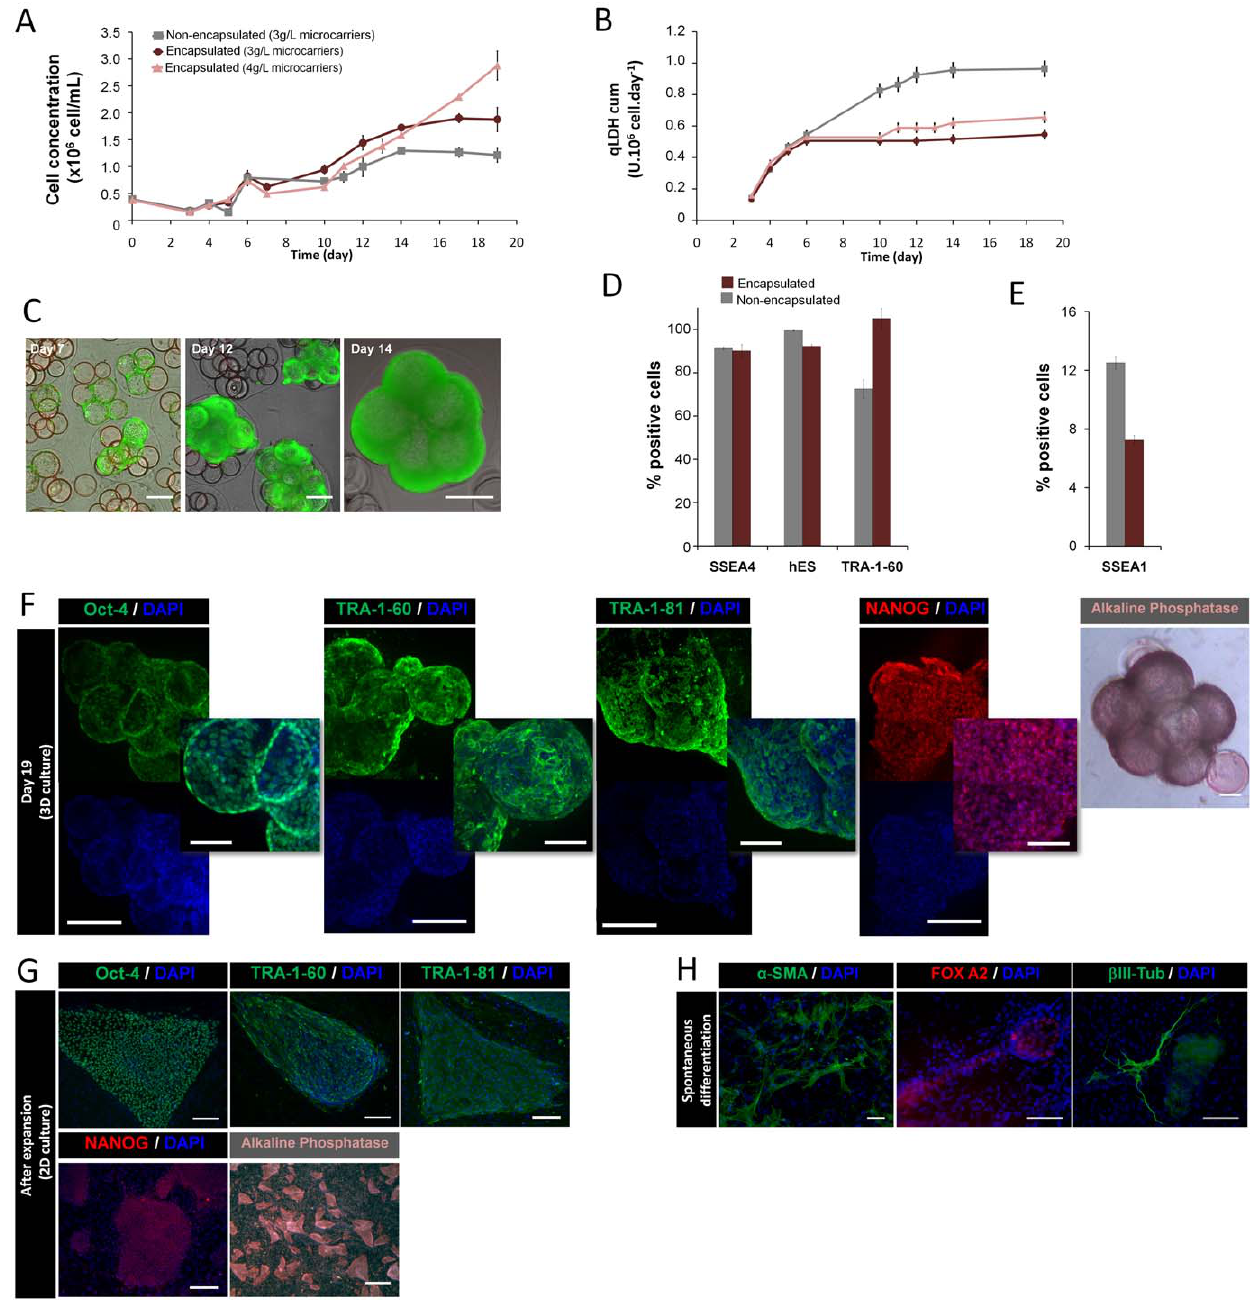
Figure 3. Effect of alginate microencapsulation on the expansion of hESCs immobilized on microcarriers. hESCs were immobilized on Matrigel-coated microcarriers (2 g/L) and encapsulated at day 6. Before microencapsulation empty coated microcarriers (1 g/L and 2 g/L) were added. Non-encapsulated (grey) and encapsulated hESCs using 3 g/L (purple) and 4 g/L (pink) of microcarriers were cultured in spinner vessels. (A) Growth curve expressed in terms of cell number per volume of medium. Error bars denote SD of 3 measurements. (B) Cumulative values of specific rates of LDH release during culture time. Error bars denote SD of 3 measurements. (C) Phase contrast and fluorescence images of encapsulated hESC cultures (on 4 g/L microcarriers) at days 7, 12 and 14. Viability analysis of cultures stained with fluoresceine diacetate (FDA-live cells, green) and propidium iodide (PI- dead cells, red). Scale bar: 200 m m. (D–H) Characterization of encapsulated hESCs immobilized on microcarriers expanded in spinner vessels: (D) Flow cytometry analysis of non-encapsulated (grey bars) and encapsulated (purple bars) hESCs immobilized on microcarriers at the end of the expansion process - percentage of SSEA-4, TRA-1-60 and hES-CellectTM (hES) and (E) SSEA-1 positive cells in relation to the 2D control culture; error bars represent SD of 2 measurements. (F) Confocal images of Oct-4, TRA-1-60, TRA-1-81 and NANOG labeling and phase contrast pictures of alkaline phosphatase (AP) activity at day 19 of encapsulated 3D culture. Nuclei were labeled with DAPI (blue). Scale bar: 200 m m, merge and phase contrast images 100 m m. (G) Immunofluorescence images of Oct-4, TRA-1-60, TRA-1-81 and NANOG labeling after expansion (2D culture). Nuclei were labeled with DAPI (blue). Scale bars: 200 m m and 1 mm for immunofluorescence and phase contrast images, respectively. (H) In vitro pluripotency analysis. Microcapsules were dissolved and hESCs were detached from the microcarriers and transferred to a monolayer of inactivated hFF. At confluence, colonies were dissociated and hESCs were able to form embryoid bodies (EBs) in non-adherent conditions and differentiated into cells from all three germ layers. Fluorescence images of differentiated cultures labeled for a –SMA ( a smooth muscle actin, mesoderm), FOX-A2 (Forkheadbox A2, endoderm) and b III-Tub ( b tubulin type III, ectoderm). Nuclei were stained with DAPI (blue). Scale bar: 100 m m. doi:10.1371/journal.pone.0023212.g003 PLoS ONE |